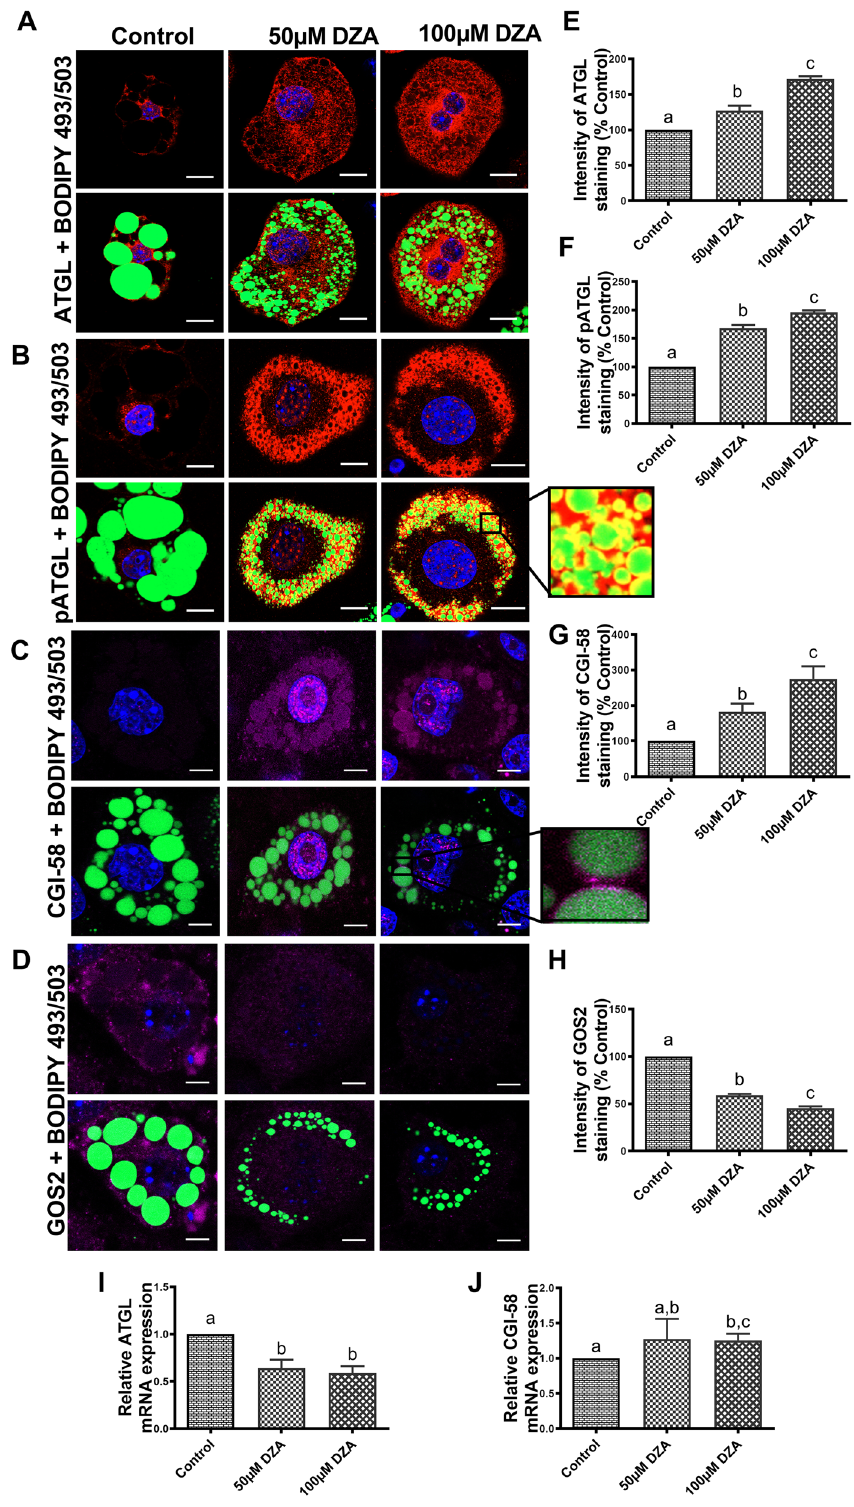
Figure 3. DZA activates ATGL in 3T3-L1 adipocytes. Immunofluorescence images showing localization of ( A ) ATGL, ( B ) pATGL-Ser(406), ( C ) CGI-58 and ( D ) GOS2 in BODIPY 493/503 and DAPI stained control and DZA-treated 3T3-L1 adipocytes (Scale bar—20 µm) with a magnified images of a representative 100 µM DZA-treated cell showing localization of pATGL-Ser(406) and CGI-58 on the LD surface. ( E ) The fluorescence intensity of ATGL, ( F ) pATGL-Ser(406), ( G ) CGI-58 and ( H ) GOS2 expression in each group of cells normalized to % of control cells, (n = 4) experiments; confocal images of 31 random cells from CGI-58 mRNA expression in control and DZA-treated 3T3-L1 adipocytes, n = 5. Data are presented as the mean ± SEM; values not sharing a common letter significantly differ from each other at p ≤